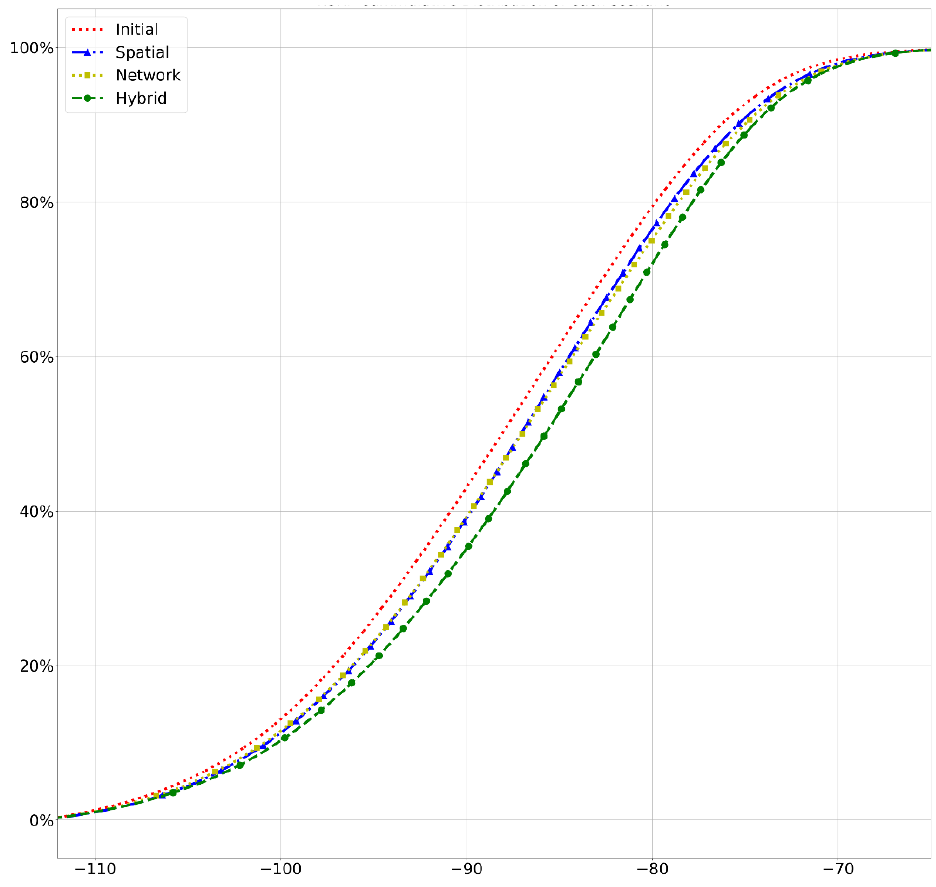
Figure 7. Performance evaluation of each algorithm performance vs. the initial scenario for RSRP (dBm) CDF.